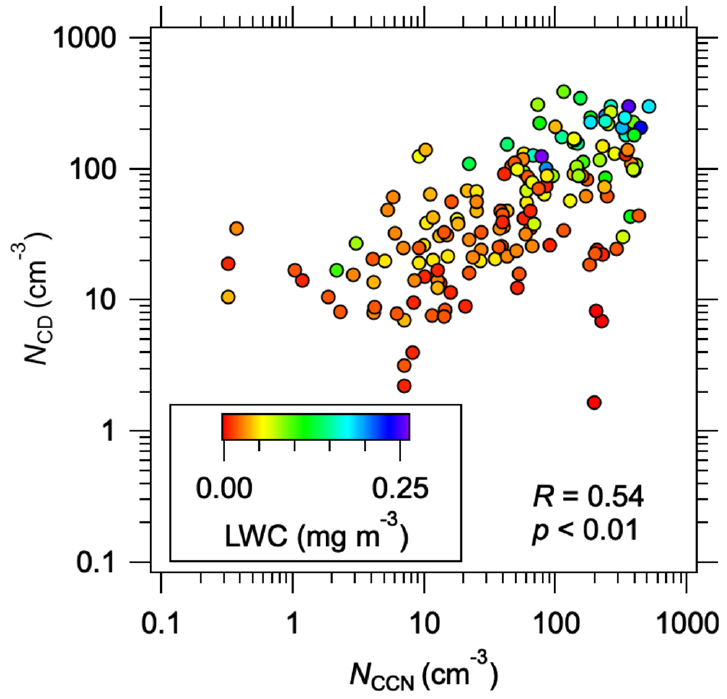
Figure 7. Effective supersaturation ( SS eff ) of clouds at the MFRS classified according to air mass origins. Number of data ( N ) for each group is indicated at the top of the panel.